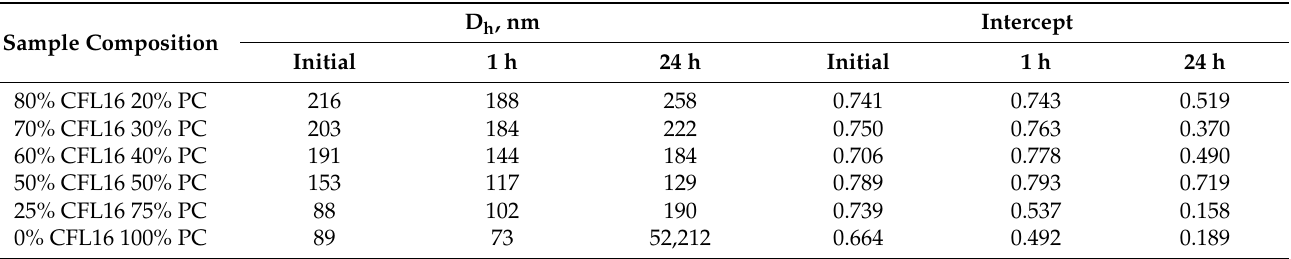
Figure 3. TEM images of 50% CFL16 50% PC cerasomes prepared via thin film hydration method. For the demonstration of cerasome stability, a test using Triton X-100 surfactant was used to dissolve the nanoparticles, with their DLS hydrodynamic diameters and correl- ogram intercepts monitored initially at 1 h and 24 h of incubation with the 5 × excess of surfactant (Table 2). At 1 h of incubation, the observed diameter was not significantly altered (within 50 nm of deviation from the original), and the samples containing 75% and 100% PC as bilayer-forming material demonstrated the most significant increase in size, with the 100% sample failing to produce a meaningful DLS result at 24 h of incubation. The value of the correlogram intercept is a measure of the quality of the size analysis using DLS; optimally, the values should be closer to 1.0, and values above 0.7 usually represent reliable results. In the case of nanoparticles formed with 75% PC and 100% PC, the intercept value is the lowest after 24 h of incubation, which indicates that DLS-distinguishable particles are no longer present in a significant amount. Table 2. Hydrodynamic diameters and correlogram intercepts evaluated by DLS for hybrid PC-CFL16 cerasomes initially after 1 h and after 24 h of incubation with 5 × molar excess of Triton X-100 surfactant.